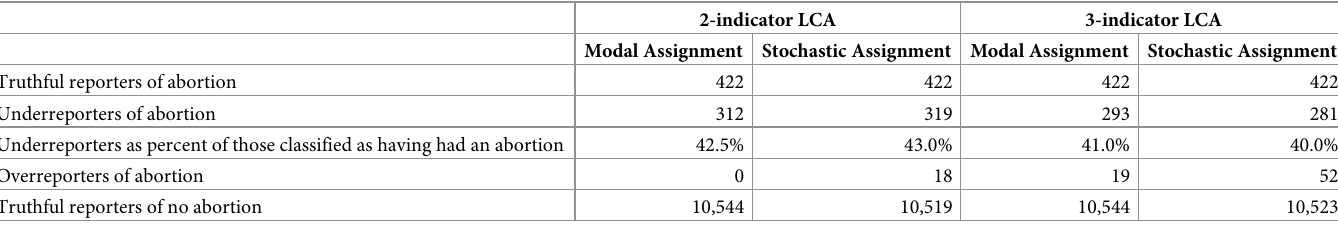
Table 3. Abortion reporting behaviors